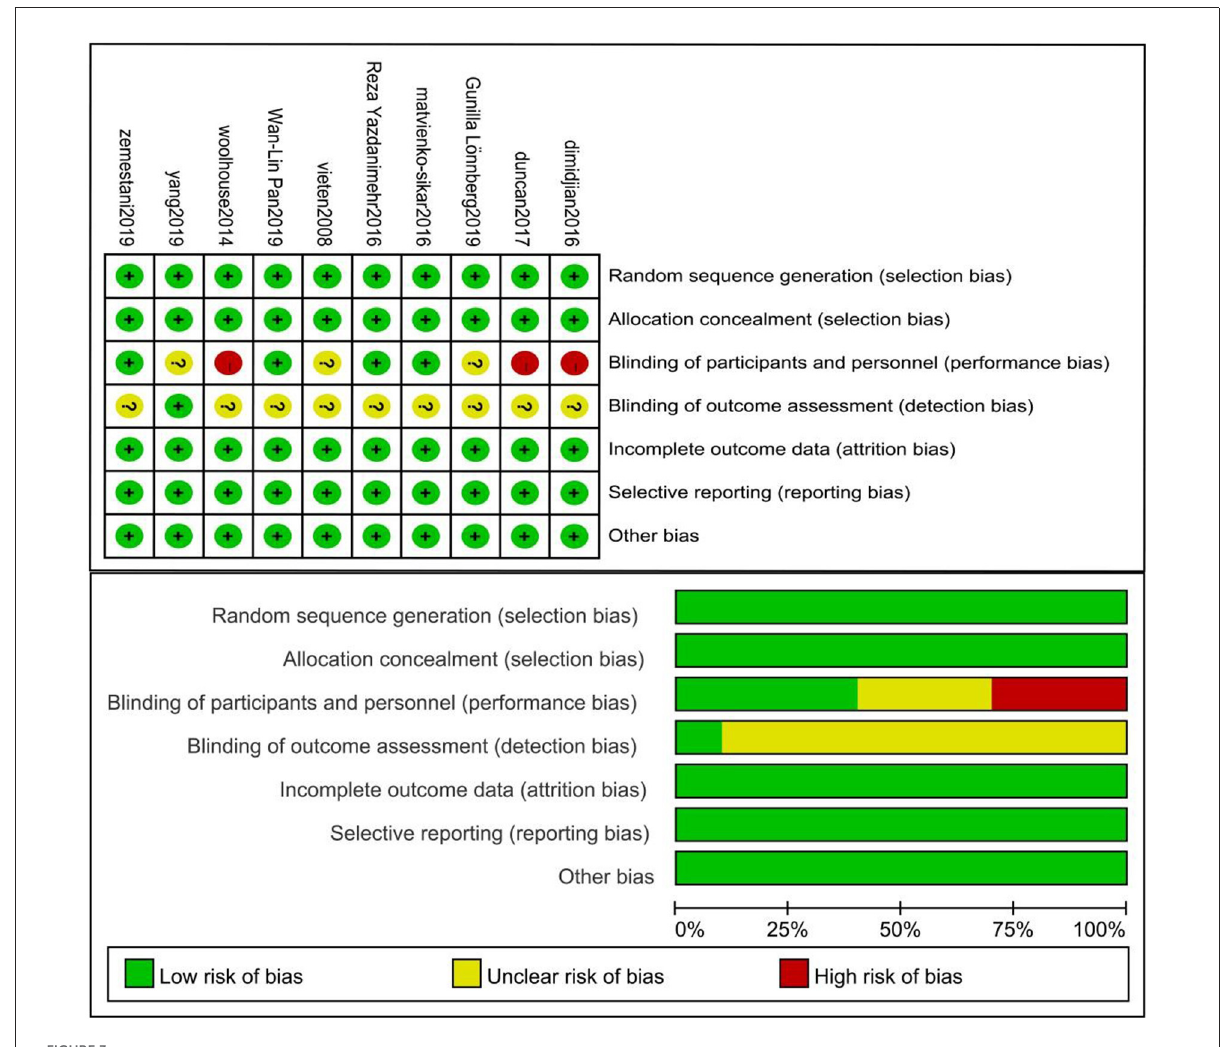
FIGURE3 Risk of bias of the included studies.